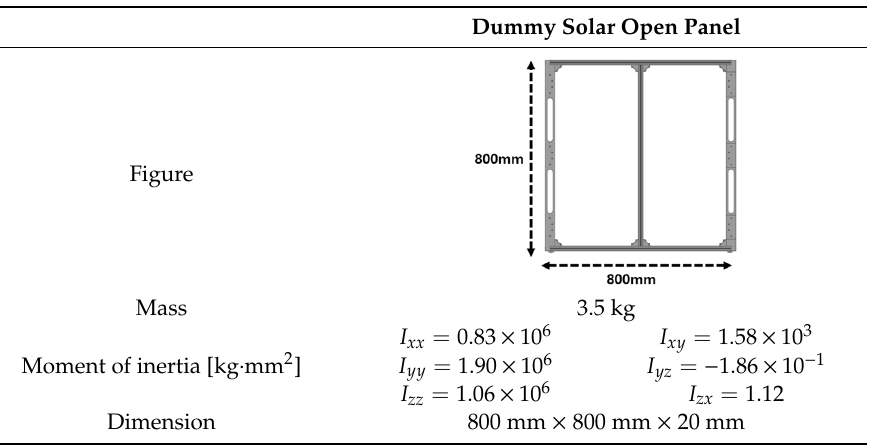
Table 3. Mass properties of dummy solar open panels.